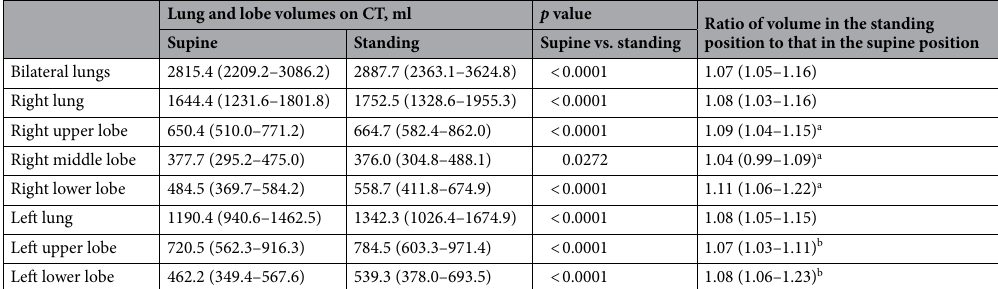
Table 2. Lung and lobe volumes between the supine and standing positions. Data are presented as medians (interquartile ranges). a The ratio of the right middle lobe volume in the standing position to that in the supine position was significantly lower than that of the right upper and lower lobe volume (both p < 0.0001). b The ratio of the left lower lobe volume in the standing position to that in the supine position was significantly greater than that in the left upper lobe volume (p = 0.0005).